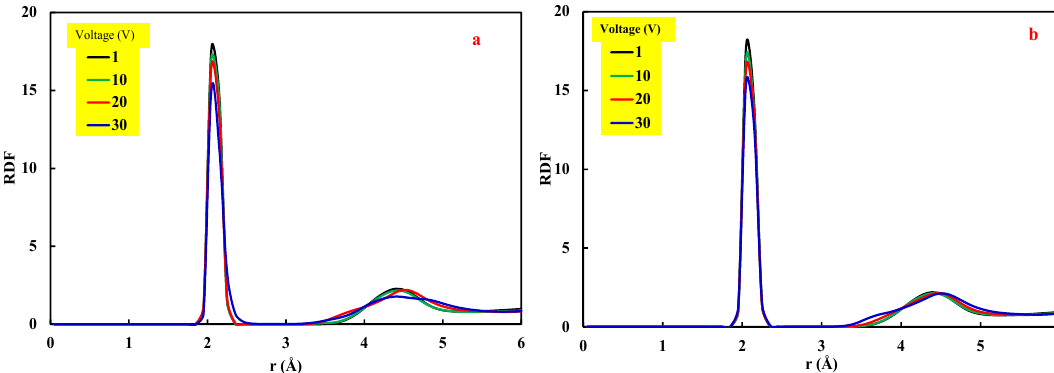
Figure 6. RDFs under various voltages: (a) RDF Ni 2+ - water in the GNS system, (b) RDF Ni 2+ - water in the BNNS system.